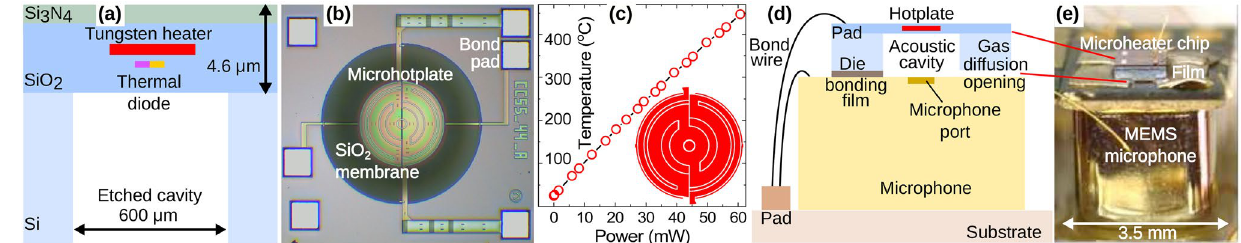
Figure 1. Device fabrication. ( a ) Structure of the CMOS microheater chip (not to scale) which employs a tungsten (W) heating element embedded in